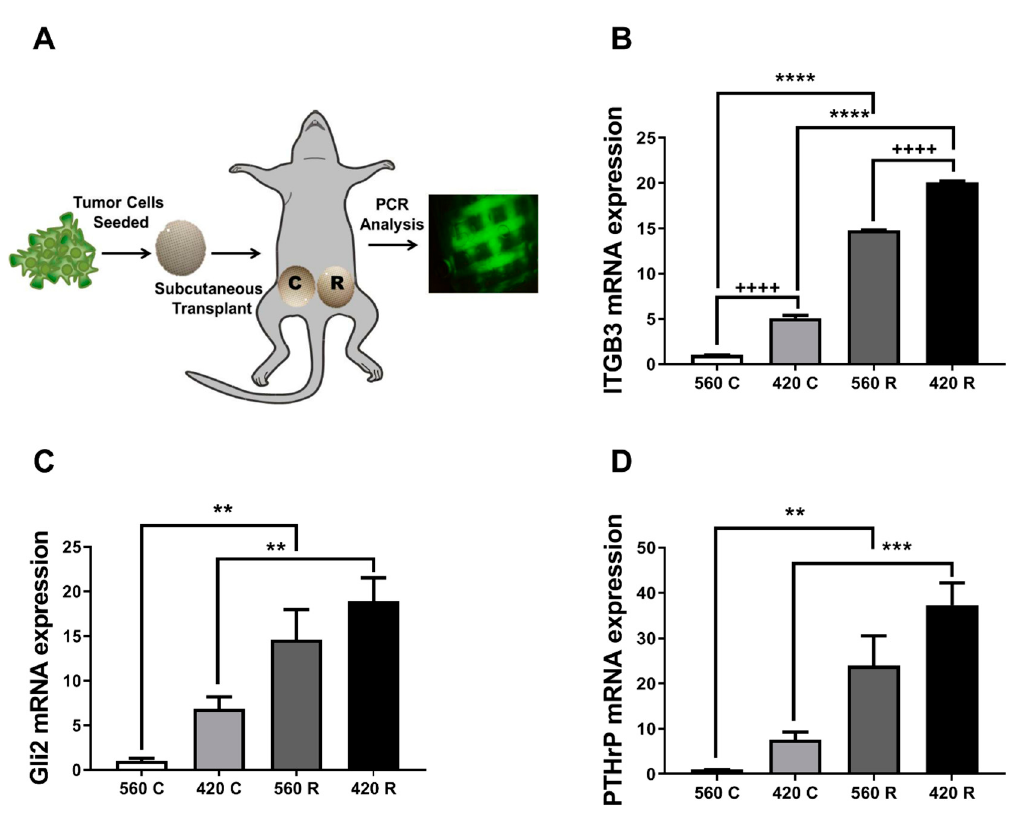
Figure 5. Effects of substrate modulus and pore size on bone metastatic gene expression in a xenograft model. ( A ) Schematic of animal model. Scaffolds were seeded with 1 × 10 6 MDA-MB-231-GFP cells and implanted subcutaneously in the abdomen. After 3.5 weeks, scaffolds were harvested for qRT-PCR analysis to assess ( B ) ITGB3 , ( C ) Gli2 , and ( D ) PTHrP mRNA expression. mRNA expression was significantly upregulated on 420R scaffolds as compared to 560C 3D scaffolds. Data presented as fold change over 560C. Two-way ANOVA. Compliant vs. rigid, ** p < 0.01, *** p < 0.001, **** p < 0.0001. 560 vs. 420, ++++ p < 0.0001.